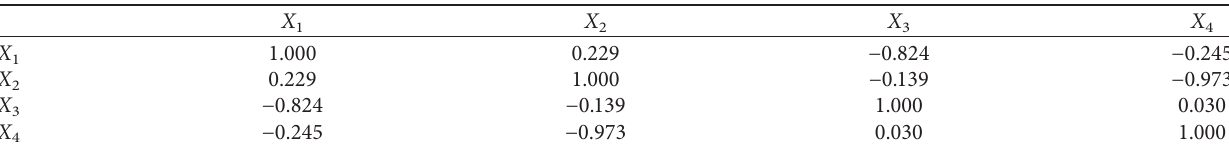
Figure 6: Estimated MSEs for n � 100, p � 3, 7, d � 0.5, sigma � 5, and different values of rho. (a) n � 30, p � 3, sigma � 5, and d � 0.5. (b) n � 30, p � 7, sigma � 5, and d � 0.5. (c) n � 100, p � 3, sigma � 5, and d � 0.5. (d) n � 100, p � 7, sigma � 5, and d � 0.5. Table 9: Correlation matrix.